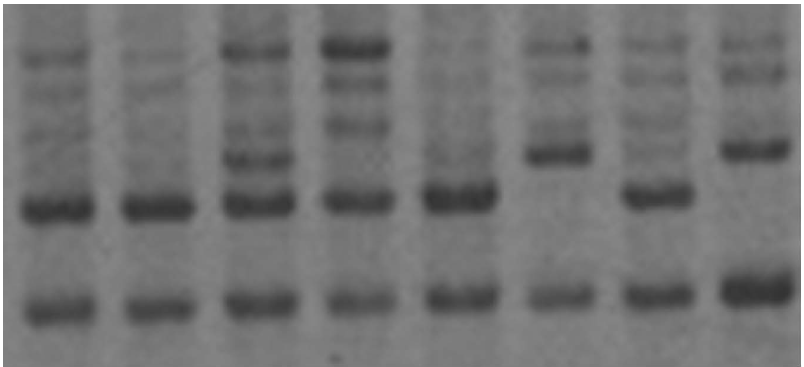
Figure 5. Polymorphism of primer CCM46 among 8 Callosobruchuschinensis genotypes.